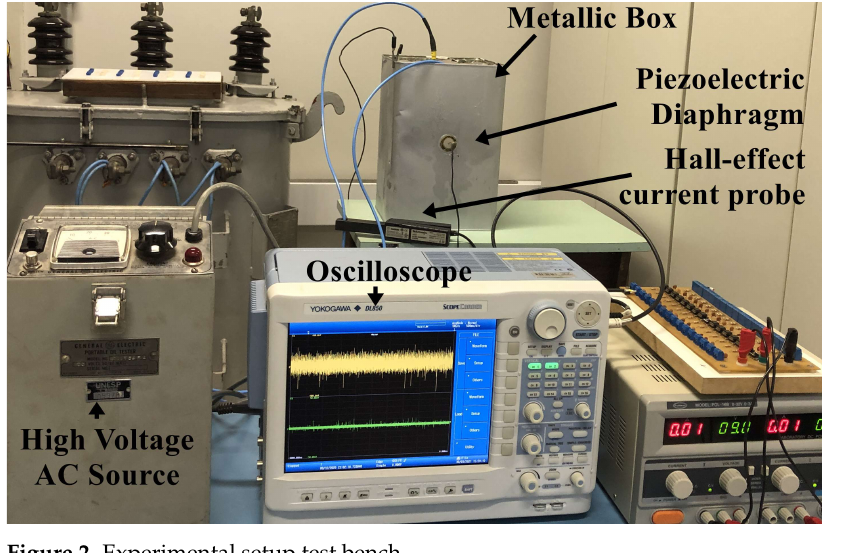
Figure 2. Experimental setup test bench.